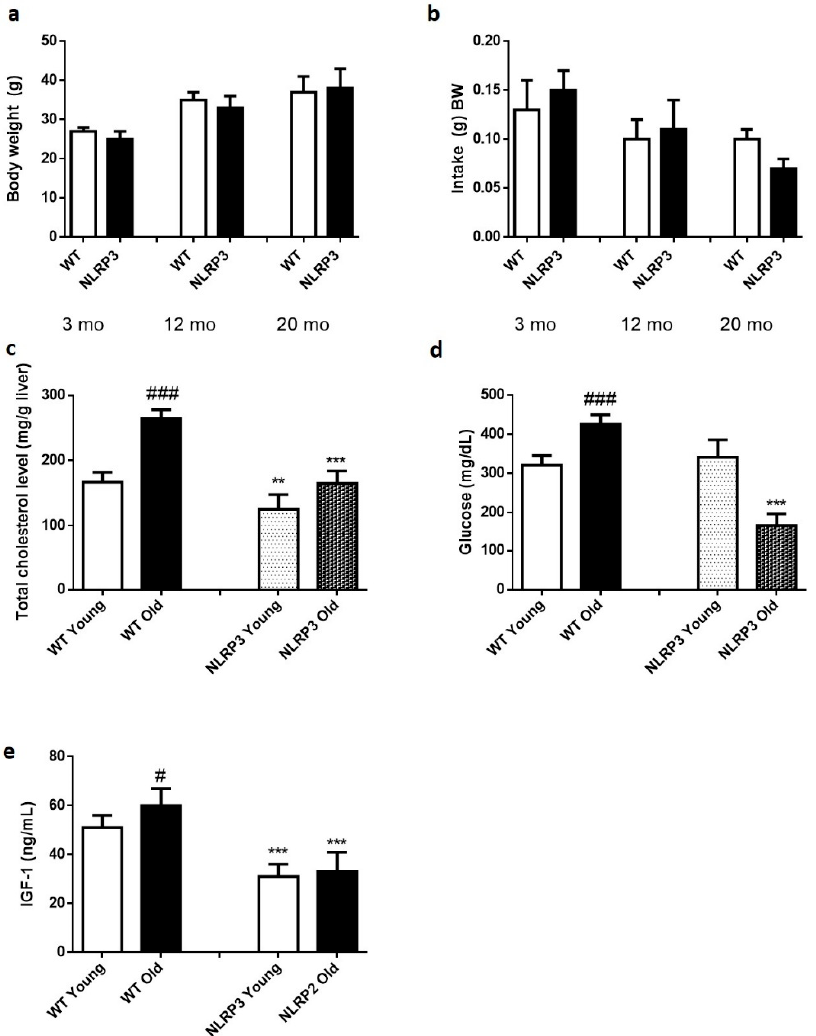
Figure 1. Biochemical parameters of WT and NLRP3 − / − mice. ( a ) Changes in body weight along 20 months. ( b ) Food intake (g) BW along 20 months. ( c ) Total cholesterol level (mg / g liver). ( d ) Glucose level (mg / dL). ( e ) IGF-1 levels (ng / mL). All data are shown as the means ± SEM ( n = 8). ** p ≤ 0.01 / *** p ≤ 0.001 (WT Young / Old vs. NLRP3 Young / Old); # p ≤ 0.05 / ### p ≤ 0.001 (WT Young vs. WT old).